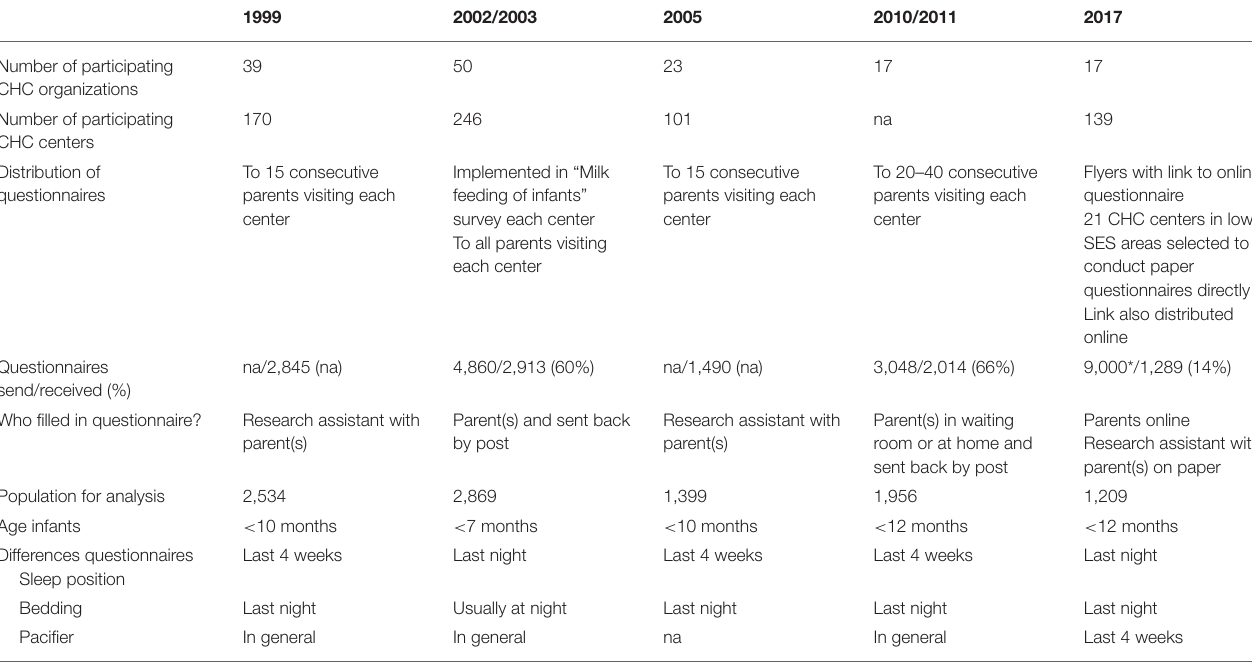
TABLE 1 | Summary method of data ascertainment and differences in questionnaires.